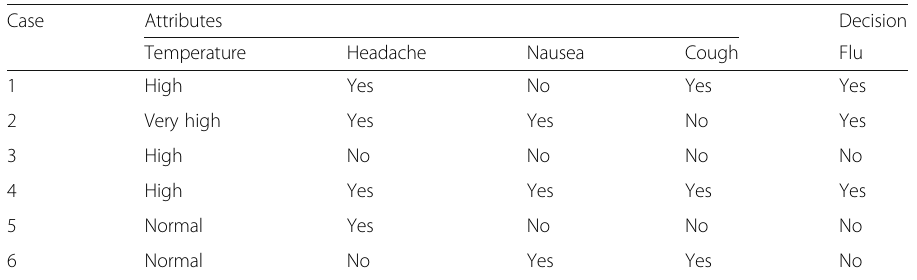
Table 1 A decision table for flu